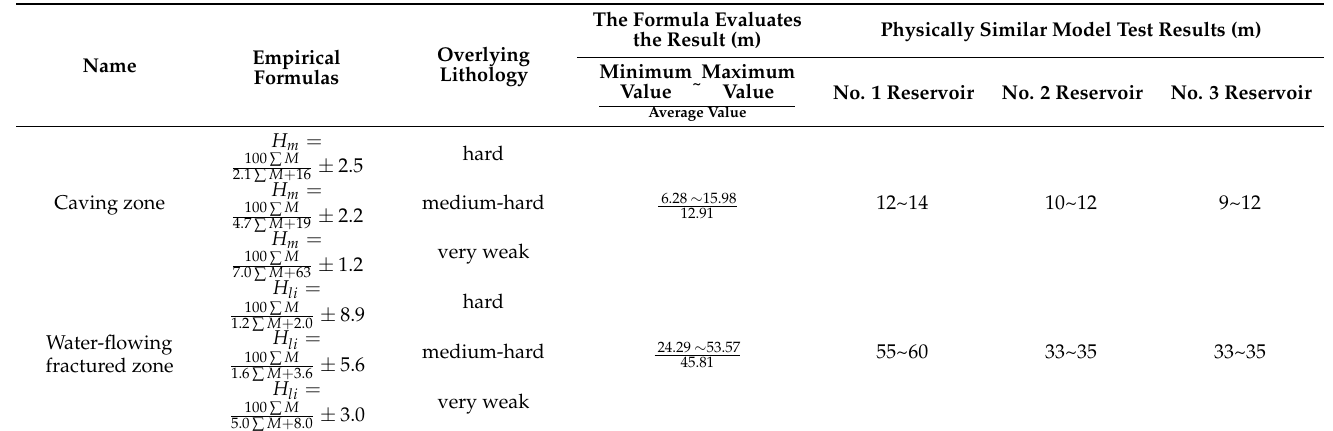
Table 2. The heights of the caving zone and the water-flowing fissure zone were determined by empirical calculations and physically equivalent models.